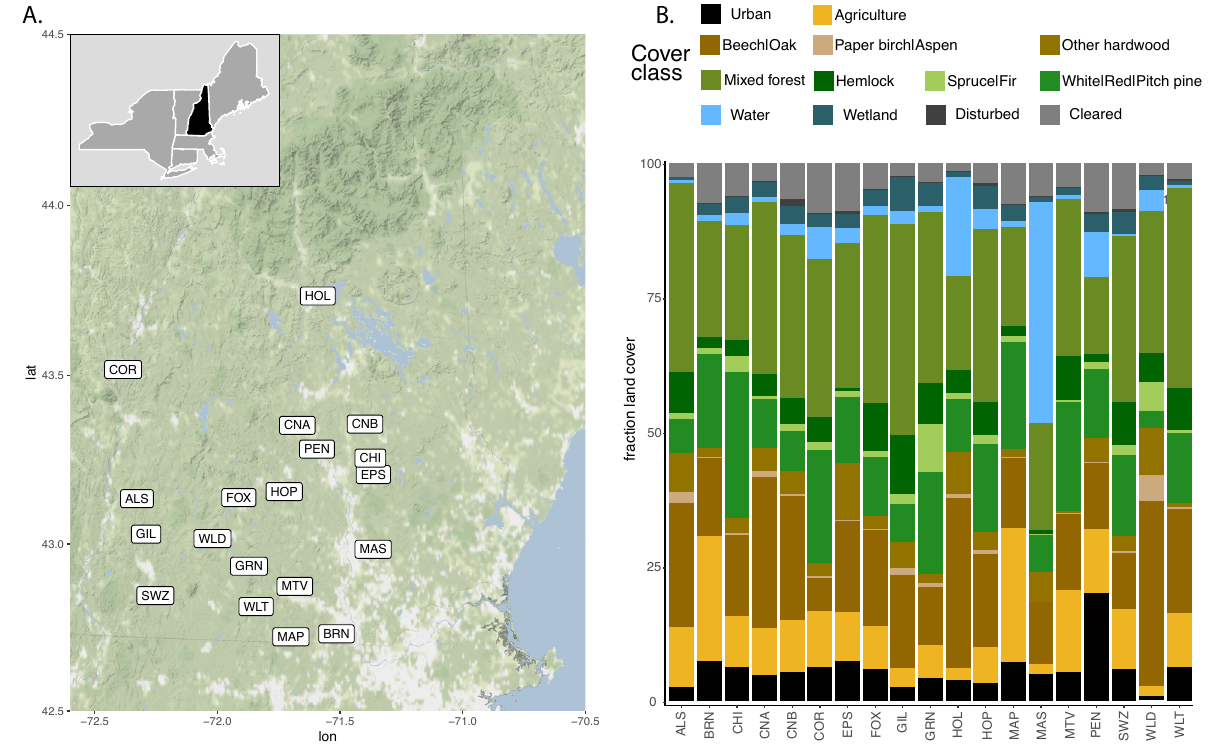
Figure 1. NH bat sample locations and landcover. ( a ) Guano samples collected throughout New Hampshire (dark state location of inset map) at particular locations (labels). Locations are abbreviated by 3-letter codes to reflect a particular New Hampshire town: ALS, Alsted; BRN, Brown Lane, Hollis; CHI, Chichester; CNA, Canterbury; CNB, Canterbury; COR, Cornish; EPS, Epsom; FOX, Fox State Forest, Hillsborough; GIL, Gilsum; GRN, Greenfield; HOL, Squam Science Center, Holderness; HOP, Hopkinton, MAP, Maple Hill, Hollis; MAS, Massabesic Audubon Center, Auburn; MTV, Mont Vernon; PEN, Penacook; SWZ, Swanzey; WLD, Willard Pond, Antrim; WLT, Wilton. ( b ) Fraction of land cover type within a 2500 m radius at collection site. Map created using a custom R script available at https:// github. com/ devon orour ke/ nhgua no/ blob/ master/ scrip ts/r_ scrip ts/ mappl